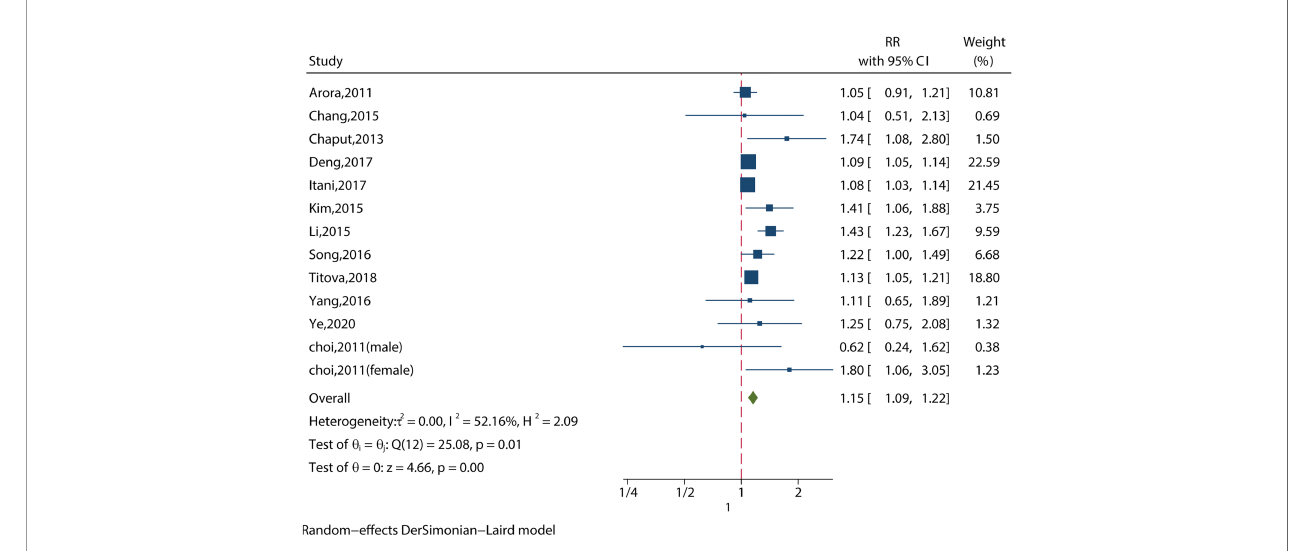
FIGURE 2 | Meta-analysis of the association between short sleep and risk of metabolic syndrome in the most ‐ adjusted